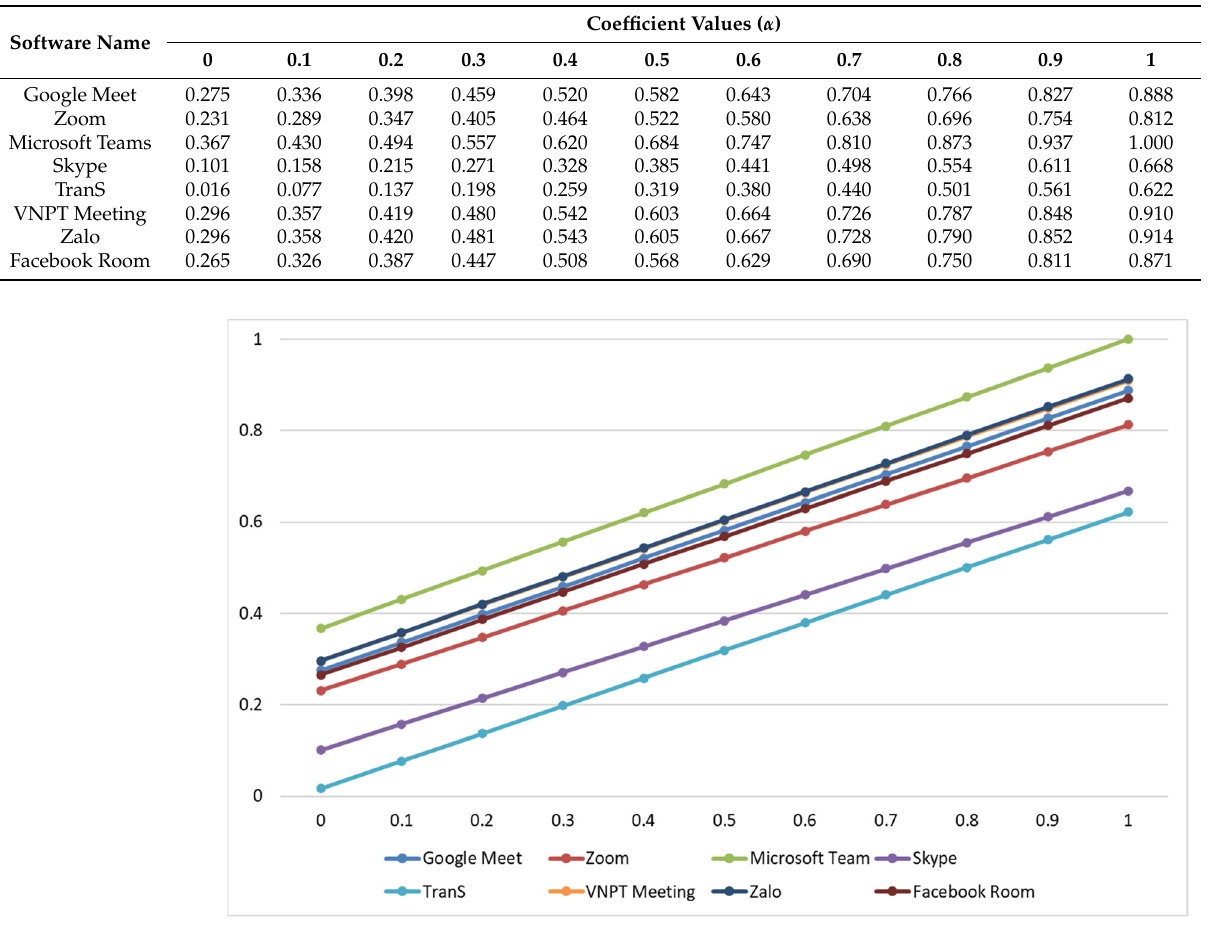
Table 11. Ranking of compared methods.